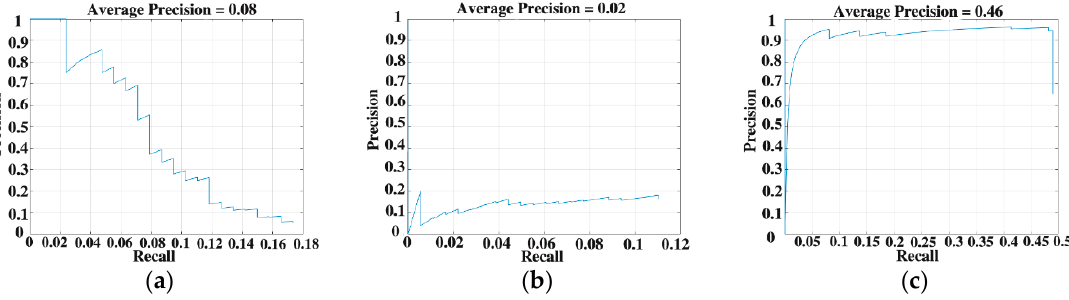
Figure 7. The three Precision and Recall Curves of ionospheric clutter, RFI and sea clutter tested on Faster R-CNN, showed in sub-figure ( a ), ( b ) and ( c ), respectively.